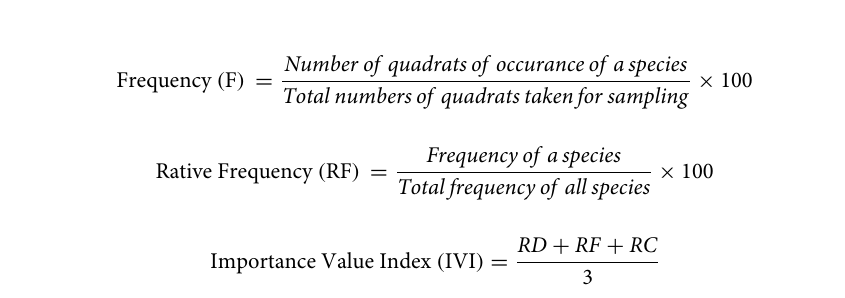
Table 1. Altitudinal ranges and coordinates data of the selected sampling locations. ( T transect, Q quadrat, W west, N north, E